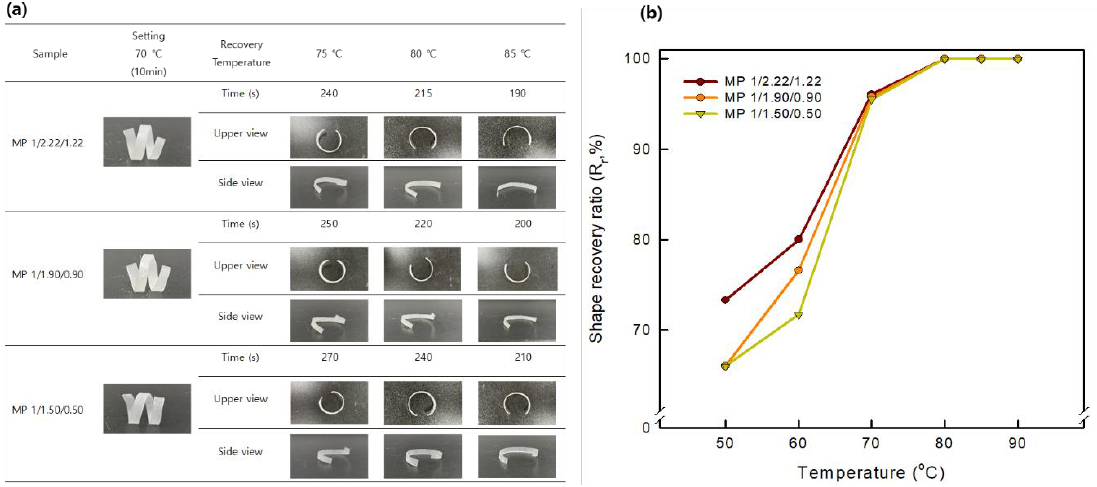
Figure 10. ( a ) Photographic images of the shape memory behaviors of the prepared SMTPUs, and ( b ) their corresponding recovery ratios (Rr) at different reheating temperatures.